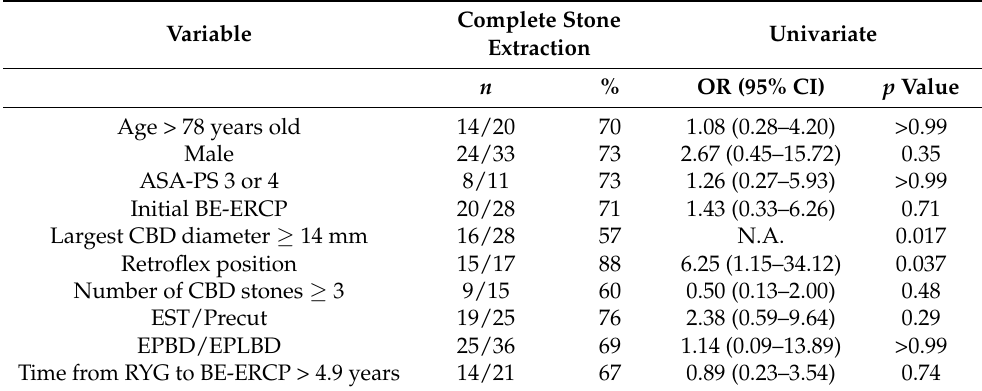
Table 6. Potential factors associated with complete stone extraction ( n = 39, largest CBD stone size ≥ 10